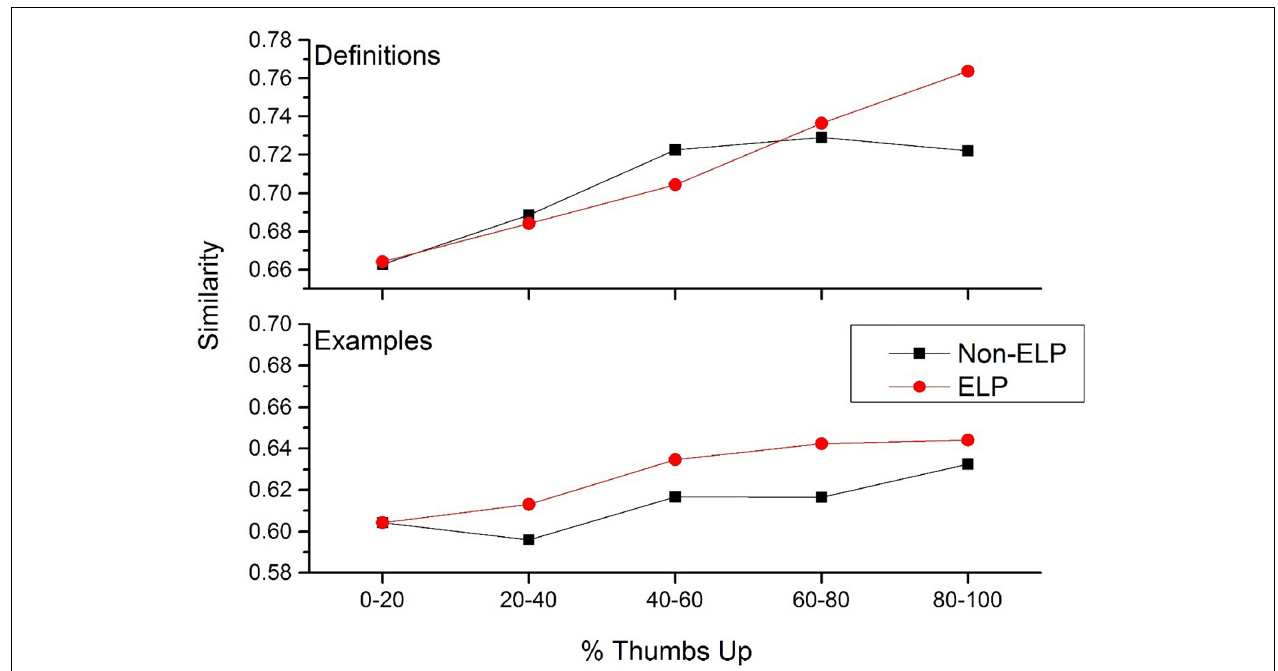
FIGURE 6 | The increase in definition and example usage similarity as an effect of increasing percent thumbs up for cue words from the English lexicon project (red lines) and cue words that were not in the English lexicon project (black lines).